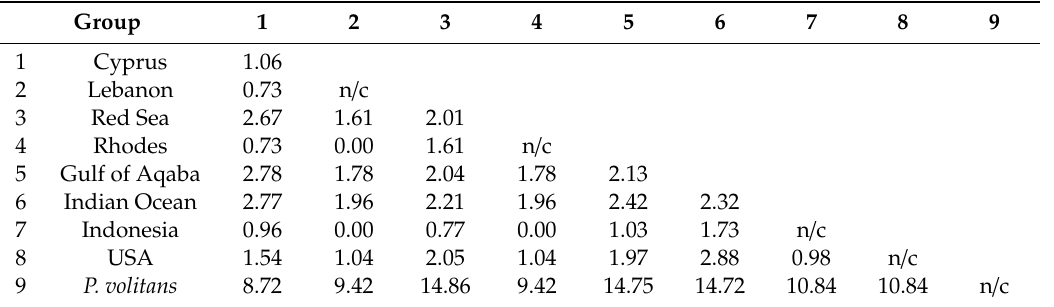
Table 2. Percentage sequence divergence (p-distance) among taxa and / or geographical groups for the CR gene. Values at the diagonal are within group